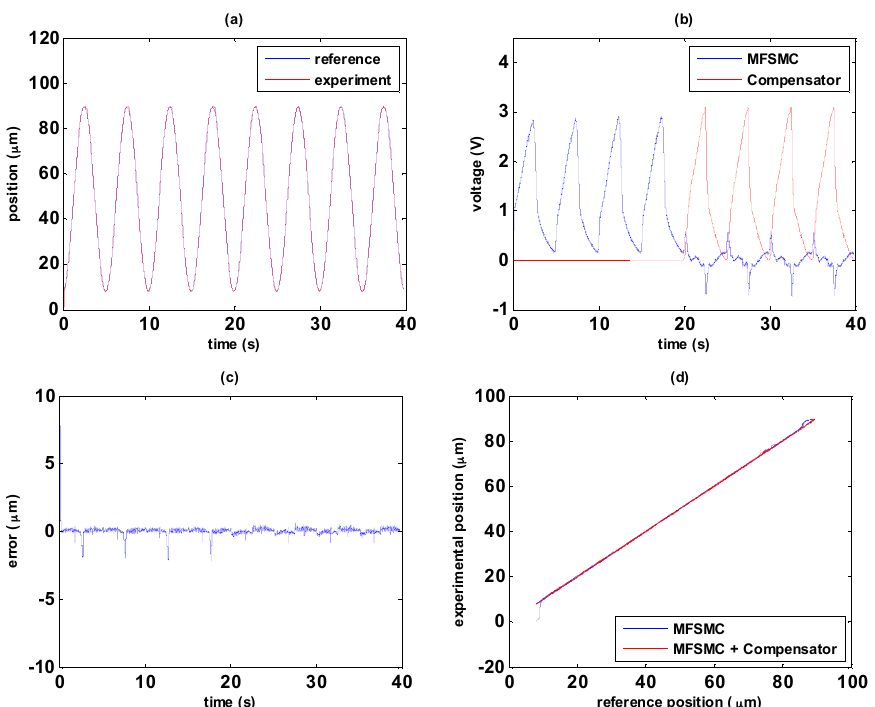
Figure 14. Comparison of PID path control with and without the hysteresis compensator: ( a ) path tracking responses; ( b ) signals of PID controller and the hysteresis compensator; ( c ) control errors; ( d ) linear relationship between reference and experimental positions.